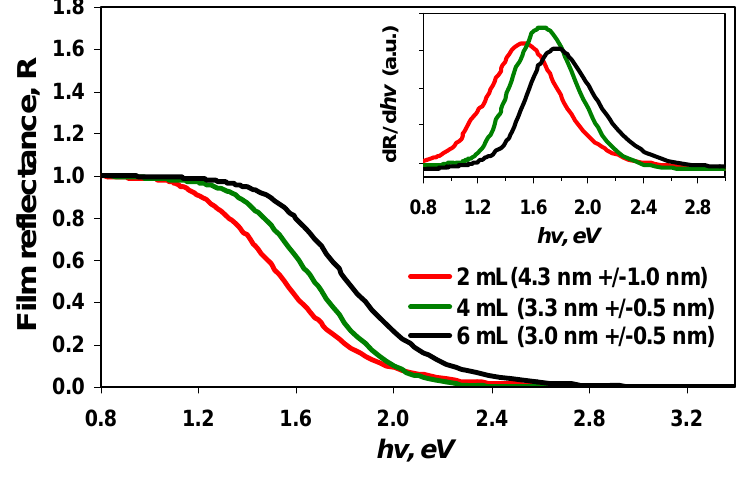
Figure 6. Reflectance spectra (normalised) of films that cast from different size nanoparticles made in the presence of 2, 4 and 6 mL TEA. Inset: The first derivative of film reflectance versus incident photon